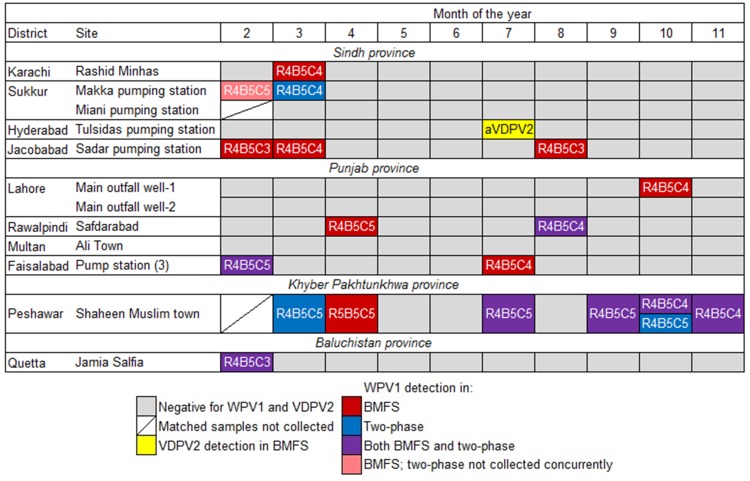
Detection of wild poliovirus type 1 (WPV1) and vaccine-derived poliovirus type 2 (VDPV2) in bag-mediated filtration system (BMFS) and two-phase samples from 12 study sites in 10 Pakistani districts from February-November 2016.The genetic cluster of WPV1 isolates is shown. The VDPV2 detected was an ambiguous VDPV2 (aVDPV2) with 12 nucleotide changes.